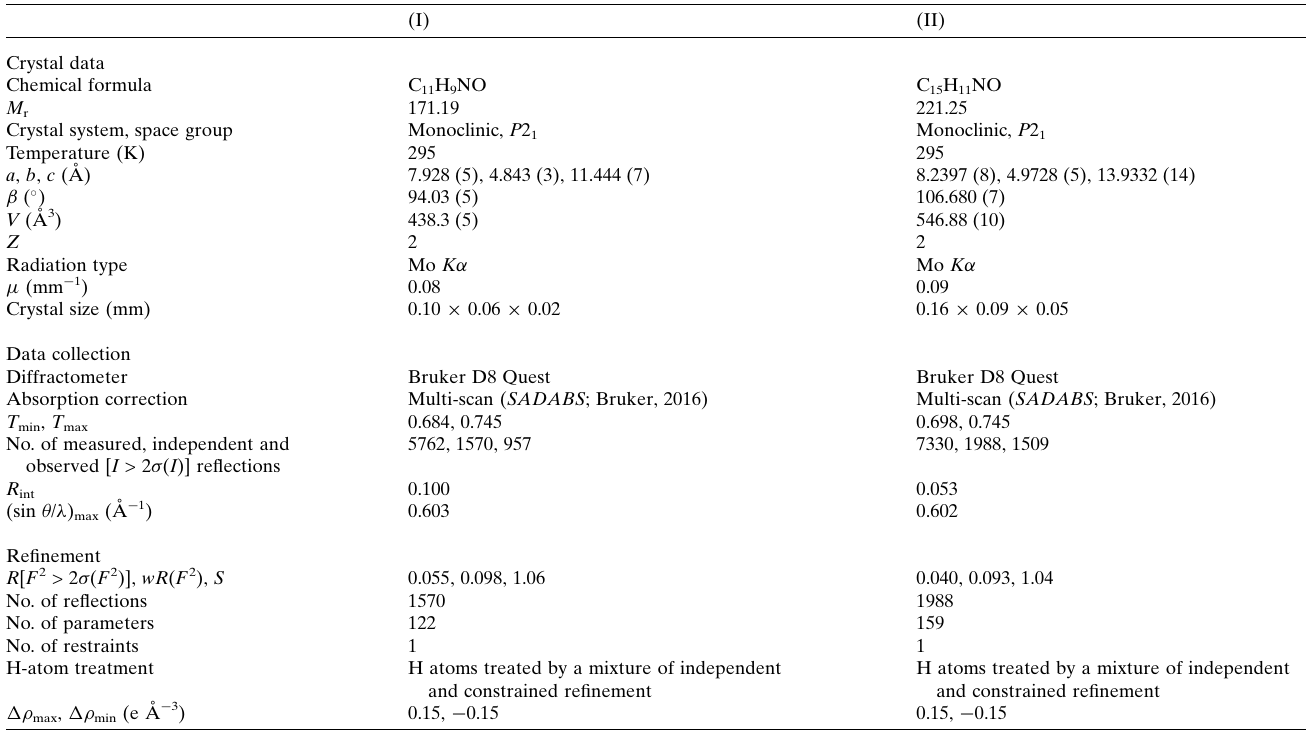
Table 4 Experimental details.